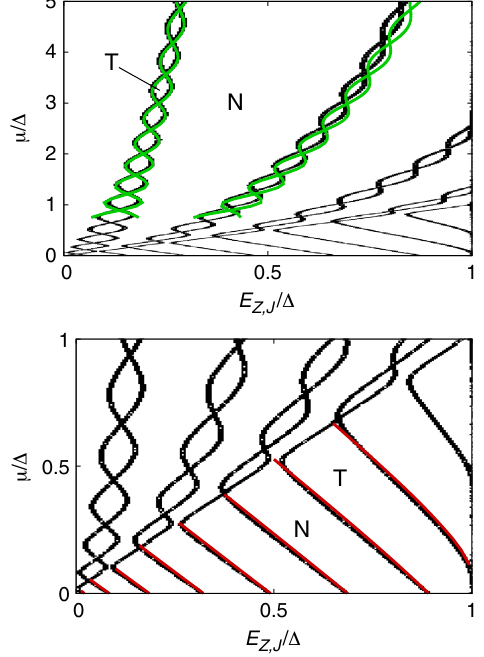
FIG. 12. Numerical phase diagram and analytical estimates for two limiting cases. The green lines show the solution in the limit B ≪ μ , Δ given by Eq. (A5) expanded to linear order in B= Δ . The normal reflection in this limit is given by r ≃ Δ = 2 μ and φ ≃ 0 . In the opposite limit μ ≪ B < Δ (red line), we use N Eq. (A11). Both panels show the same data for a width of W ¼ 14 ð m Δ Þ − 1 = 2 and ϕ ¼ 0 .